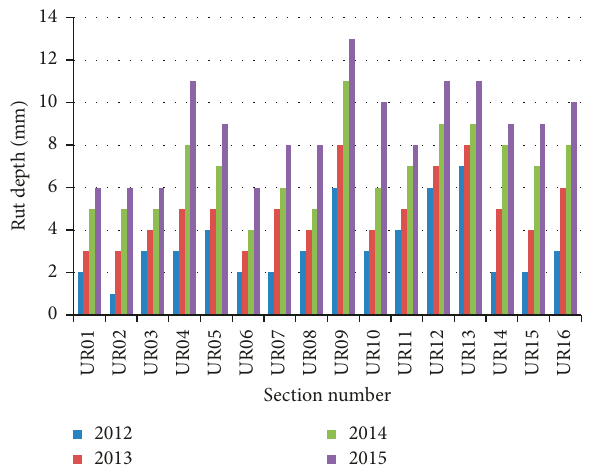
Figure 11: Progressive variation of rutting for the road sections UR01 to UR16.